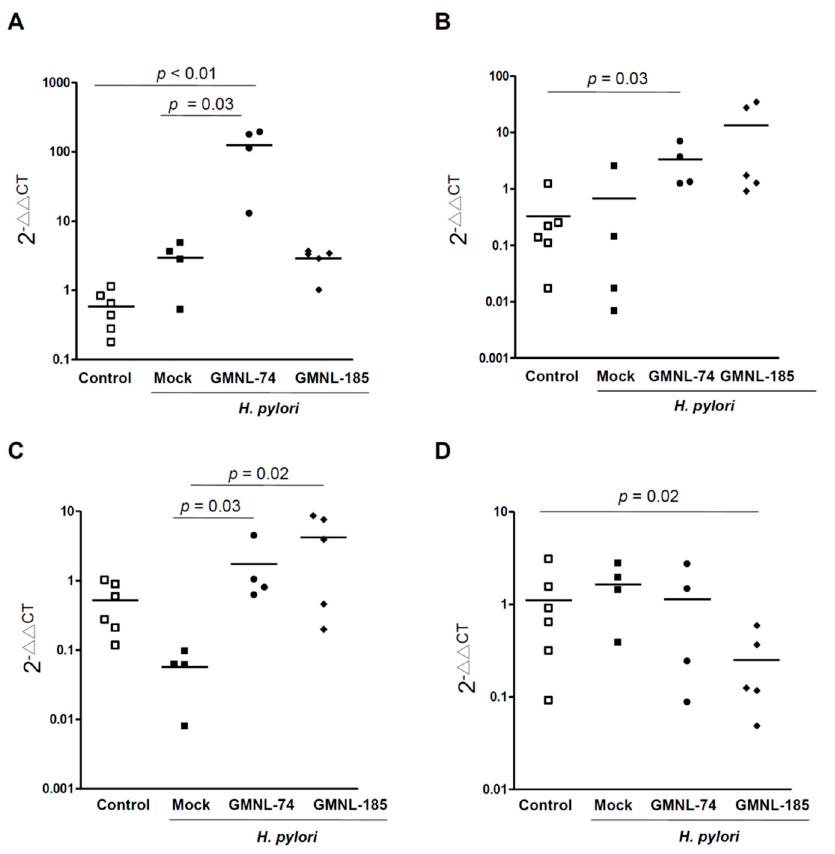
Figure 5. Probiotic Lactobacillus spp. altered the gut specific bacteria against H. pylori in the mouse stomach. Mouse stool was collected for analyzing qRT-PCR to identify the bacterial species, including ( A ) Bifidobacterium , ( B ) Proteobacteria , ( C ) A. muciniphila , and ( D ) E. coli . The alterations of gut specific bacteria were determined as described in the Materials and Methods. Statistical analysis was subjected to the Kruskal-Wallis test with post hoc test by Dunn test. p < 0.05 was considered statistically